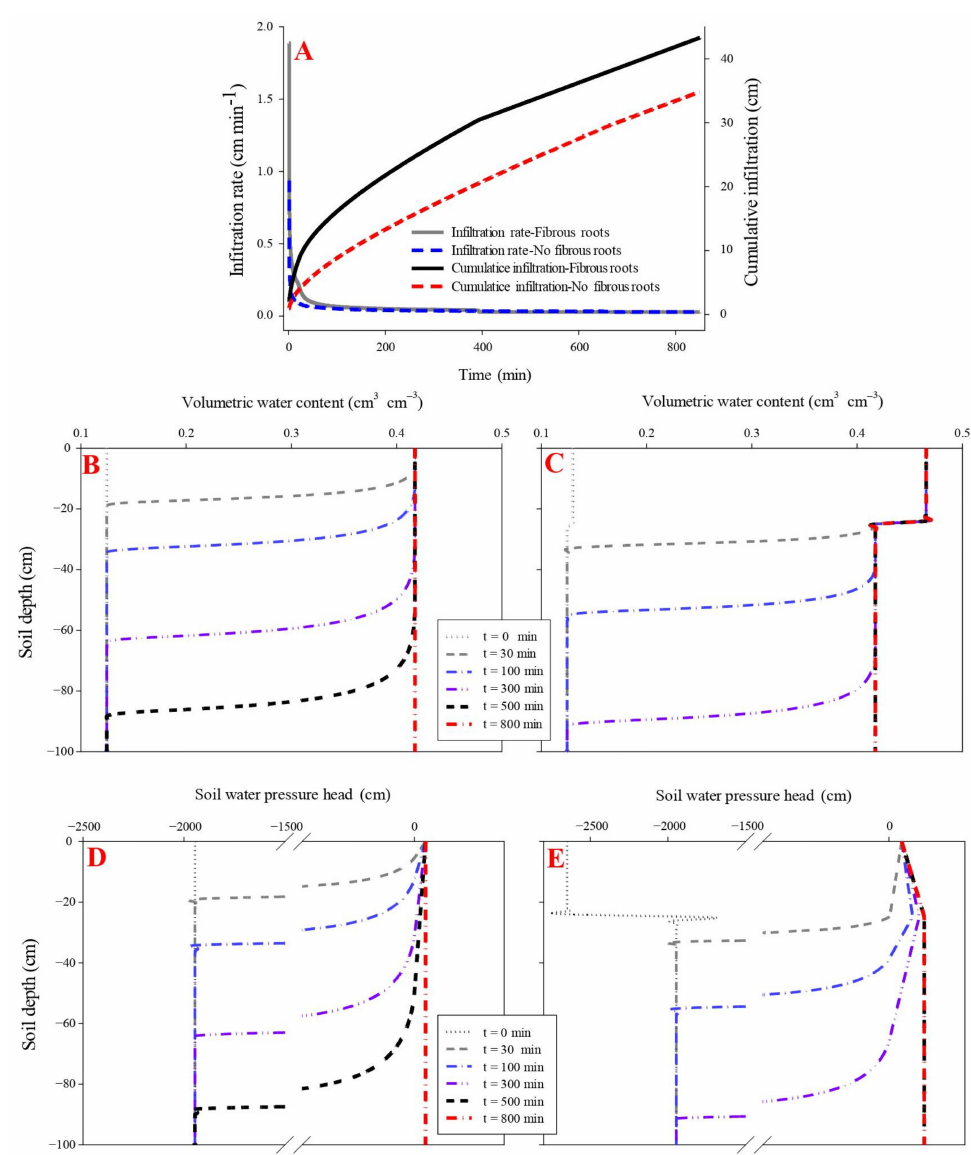
Figure 2. Effect of fibrous roots of maize on infiltration ( A ). ( B , D ) shows the dynamic variation in volumetric water content and soil water pressure head in the soil profile without fibrous maize roots. ( C , E ) shows the dynamic variation in volumetric water content and soil water pressure head in the soil profile with fibrous maize